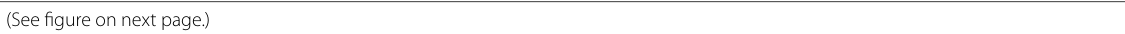
figure on next Fig. 1 The R.O.S.E. concept and the 4 phases of Fluid Therapy. Adapted according to the Open Access CC BY Licence 4.0 with permission from Malbrain et al. [9]. a Graph showing the four-hit model of shock with evolution of patients’ cumulative fluid volume status over time during the five distinct phases of resuscitation: Resuscitation (R), Optimization (O), Stabilization (S), and Evacuation (E) (ROSE), followed by a possible risk of Hypoperfusion in case of too aggressive deresuscitation. On admission patients are hypovolemic, followed by normovolemia after fluid resuscitation (EAFM, early adequate fluid management), and possible fluid overload, again followed by a phase going to normovolemia with late conservative fluid management (LCFM) and late goal-directed fluid removal (LGFR) or deresuscitation. In case of hypovolemia, O 2 cannot get into the tissues because of convective problems, in case of hypervolemia O 2 cannot get into the tissue because of diffuse problems related to interstitial and pulmonary edema, gut edema (ileus and abdominal hypertension). b The role of fluids within the R.O.S.E.